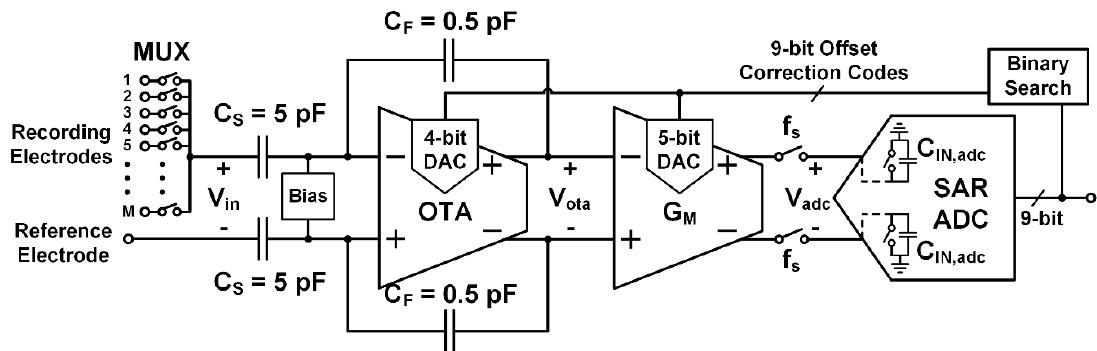
Figure 6. Diagram of the proposed rapidly multiplexed neural recording architecture. A capacitive feedback amplifier is used for pre-amplification with a gain of 10. Windowed integration sampling (WIS) is implemented with an open-loop transconductor (G M ) driving the input capacitance (C IN,adc ) of a successive approximation ADC. Mixed-signal feedback is used to reject DC offsets between the recording and reference electrodes by injecting correction signals through digital-to-analog converters (DACs) in the analog signal path.